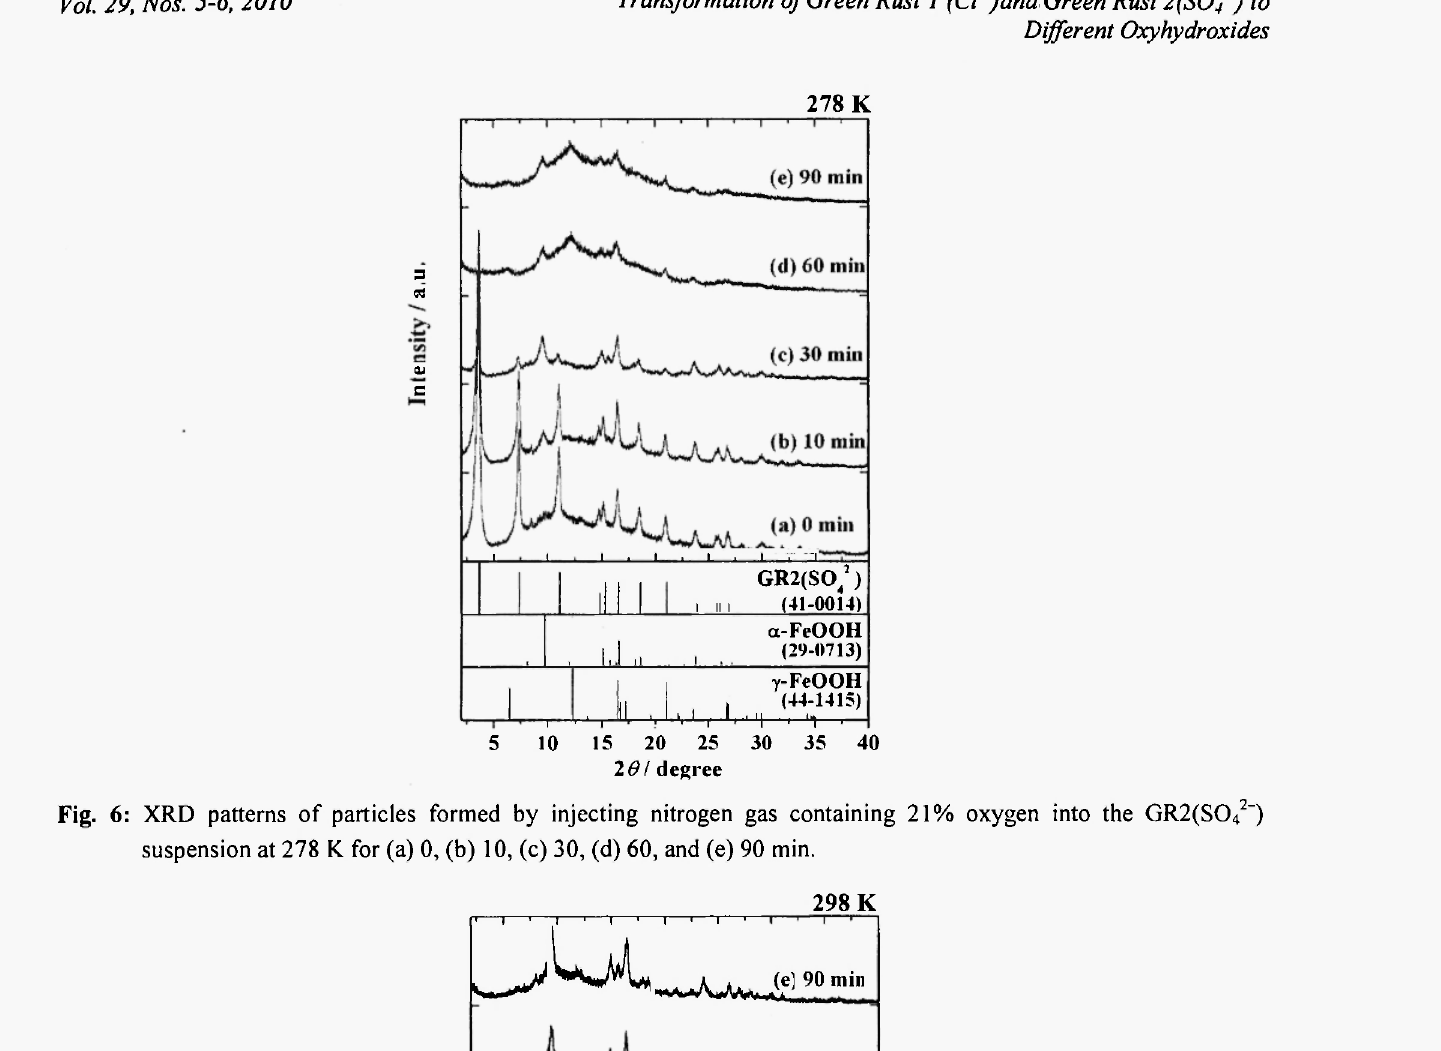
Fig. 6: XRD patterns of particles formed by injecting nitrogen gas containing 21% oxygen into the GR2(S0 4 2 ~) suspension at 278 Κ for (a) 0, (b) 10, (c) 30, (d) 60, and (e) 90 min.